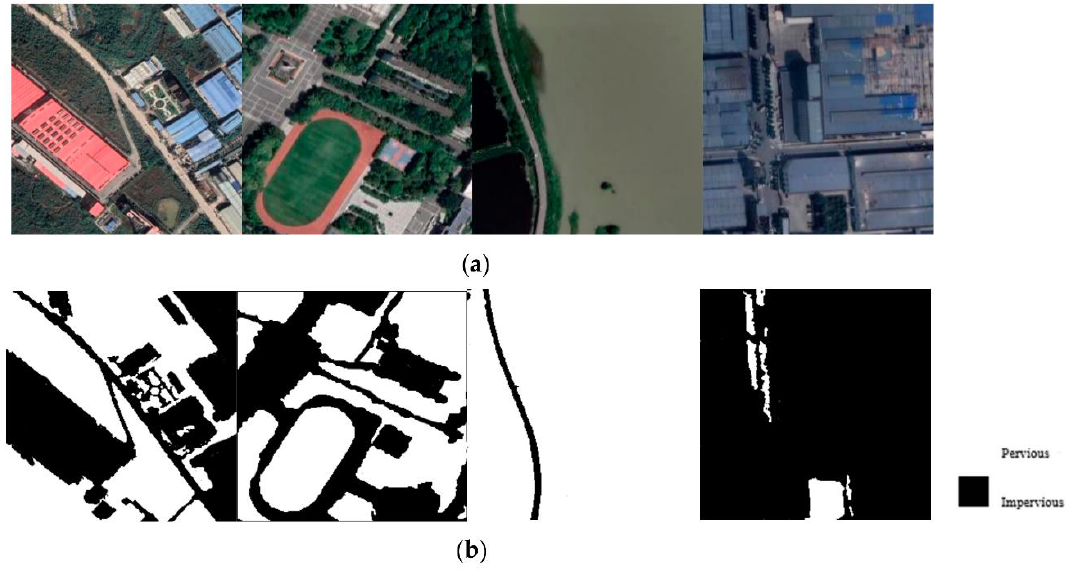
Figure 5. Example of a remote sensing impervious surface map. ( a ) Sub-map image generated after original image clipping. ( b ) Impervious surface binary map corresponding to the sub-map image.